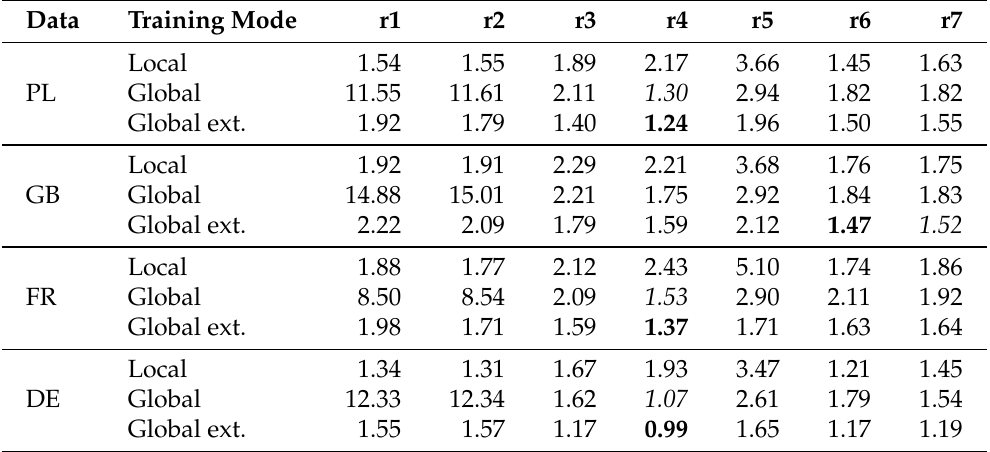
Table 1. Validation MAPE for different input patterns r1–r7 and training modes (lowest errors in bold, second lowest errors in